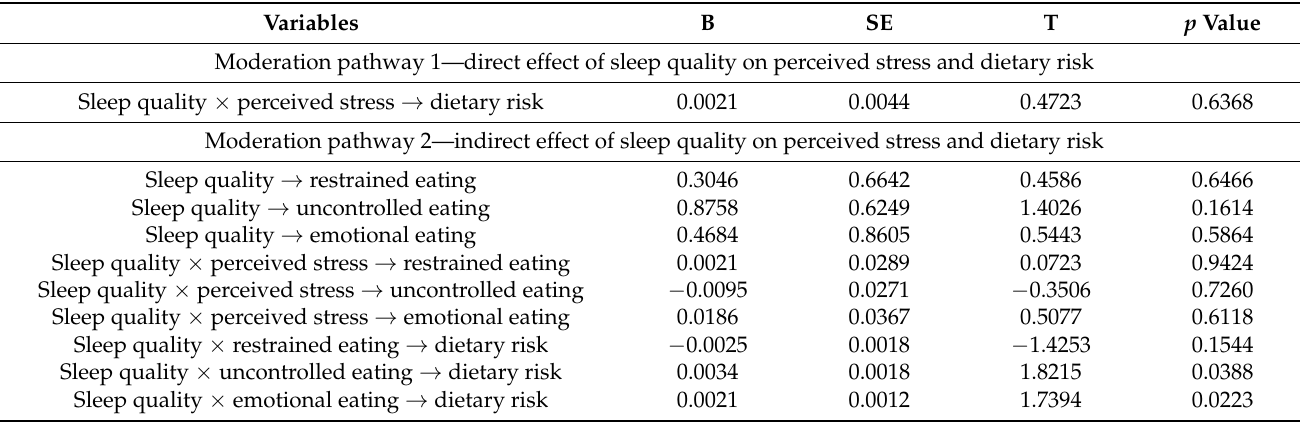
Table 6. Model 1 moderation analysis for females (sleep quality as a moderator). Variables